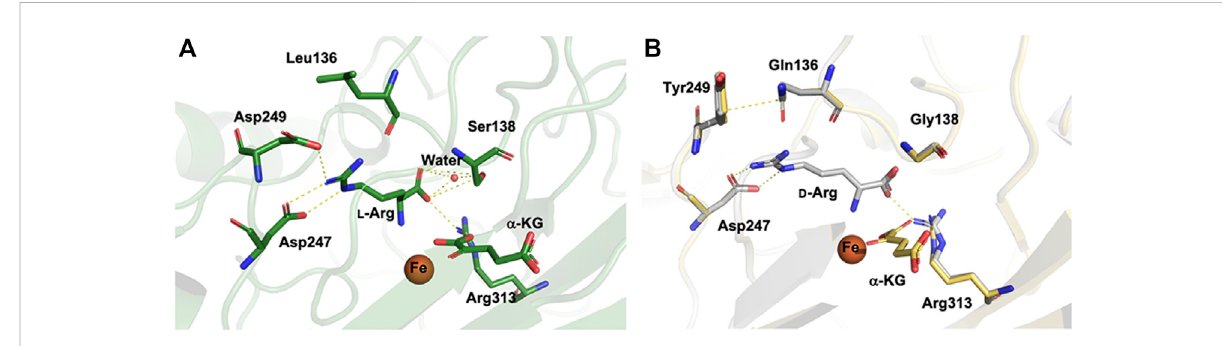
FIGURE 6 Structural comparison of CmnC L − Arg, α -kg and CmnC L136Q,S138G,D249Y . (A) Local view of the active sites of CmnC L − Arg, α -kg . (B) Superposition of the structures and the local view of the active sites of CmnC triple, α − KG ( yellow ) and CmnC triple, D − Arg ( grey ) . The electrostatics, hydrogen bond, and π – electron interactions are depicted as yellow dotted